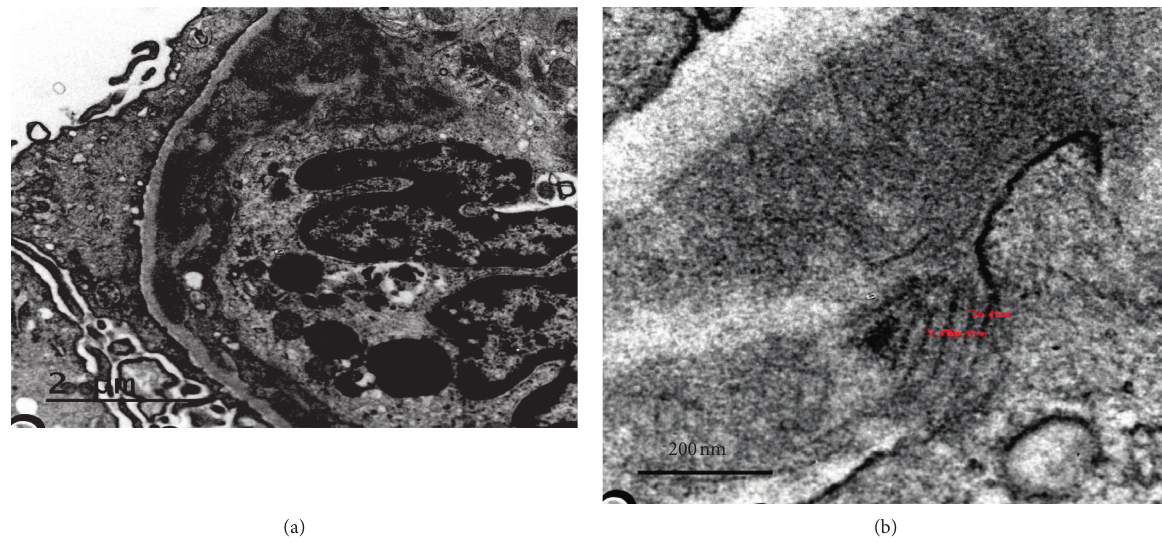
Figure 3: Electron microscopy showed subendothelial and mesangial deposits (a) (10000x); for the most part, these were nonorganized; however, there were some fibrillary deposits with parallel arrangement measuring approximately 10–15nm (b)